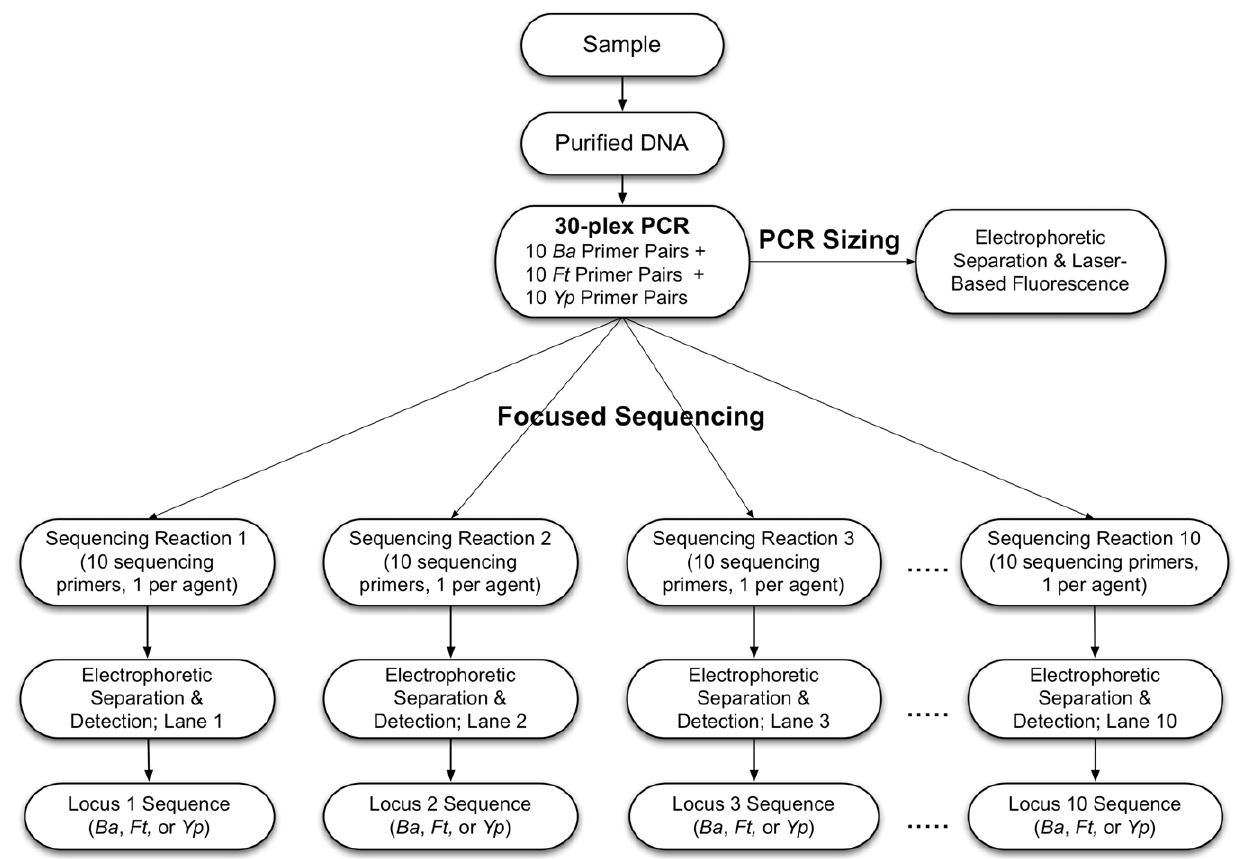
Figure 1. Flowchart illustrating process steps of the two related multiplexed assays: PCR Sizing and Rapid Focused Sequencing. In the multiplexed PCR sizing assay, the PCR reaction products are separated by microfluidic electrophoresis and detected based on labeled primers incorporated during the amplification reaction. In the Rapid Focused Sequencing assay, the multiplexed amplification utilizes the identical but unlabeled 30-plex primer set. The resulting PCR reaction products are then subjected to Sanger Sequencing followed by microfluidic electrophoresis and detection based on labeled primers incorporated during the sequencing reaction.